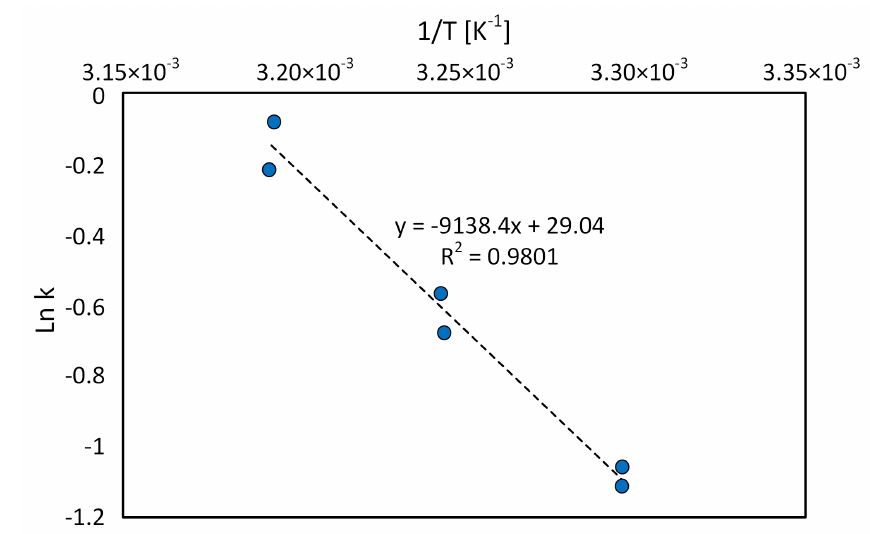
Figure 13. Natural logarithm relation from constant reaction rate of chlorine decay free from inverse